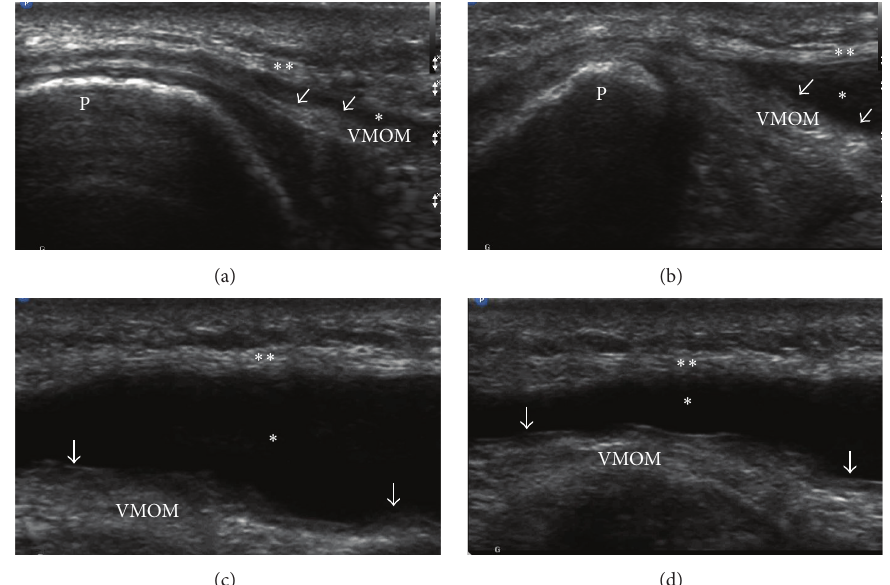
Figure 3: Using a linear transducer (Philips L12–3MHz) an area of homogenous anechoic fluid collection with scattered hyperechoic substance ( ∗ ) between subcutaneous tissue ( ∗∗ ) and superficial quadriceps fascia (arrows) was visualized. Long-axis middle suprapatellar view (a), long-axis medial suprapatellar view (b), short-axis medial suprapatellar view (c), and compressible fluid collection in short-axis suprapatellar view (d). Patellae (P) and vastus medialis oblique muscle (VMOM) look unremarkable with no signs of prepatellar bursal enlargement.